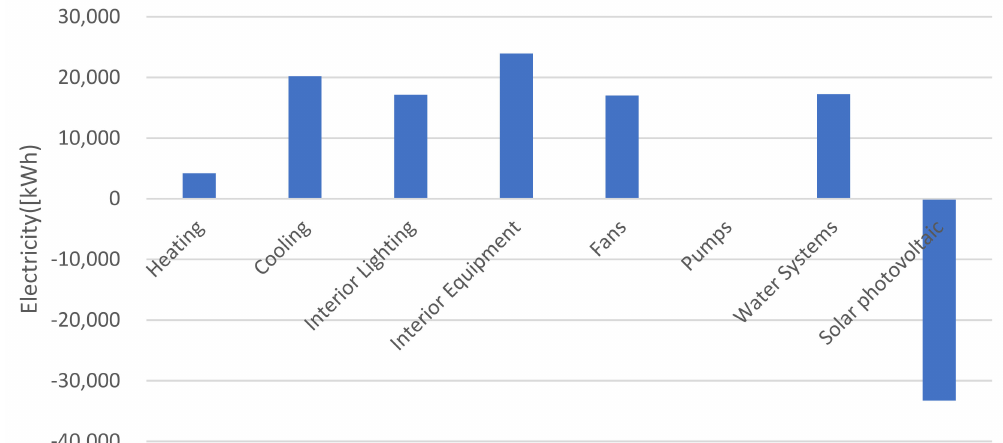
Figure 7. Comparison of power consumption and power generation of building operation.